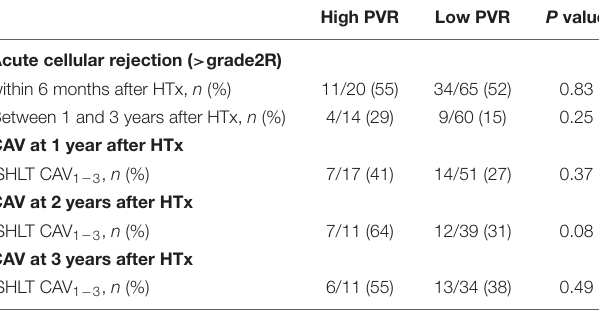
TABLE 3 | Acute cellular rejection and CAV in two